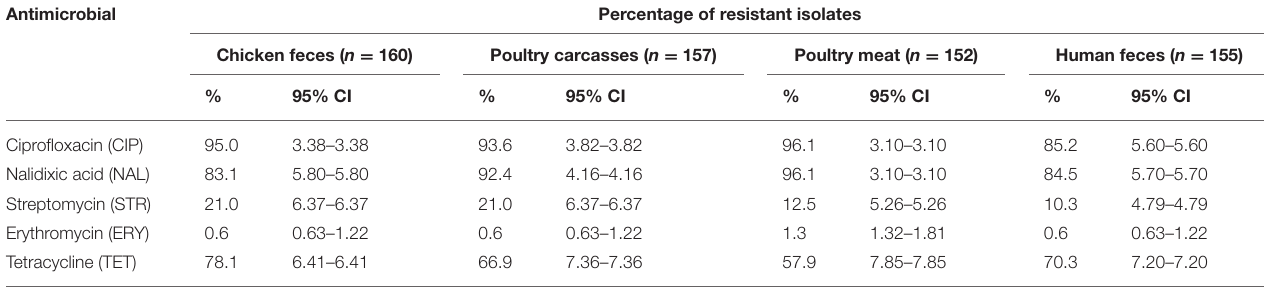
TABLE 2 | Antimicrobial resistance of C. jejuni isolated from different sources. Values are in % ± 95% CI.